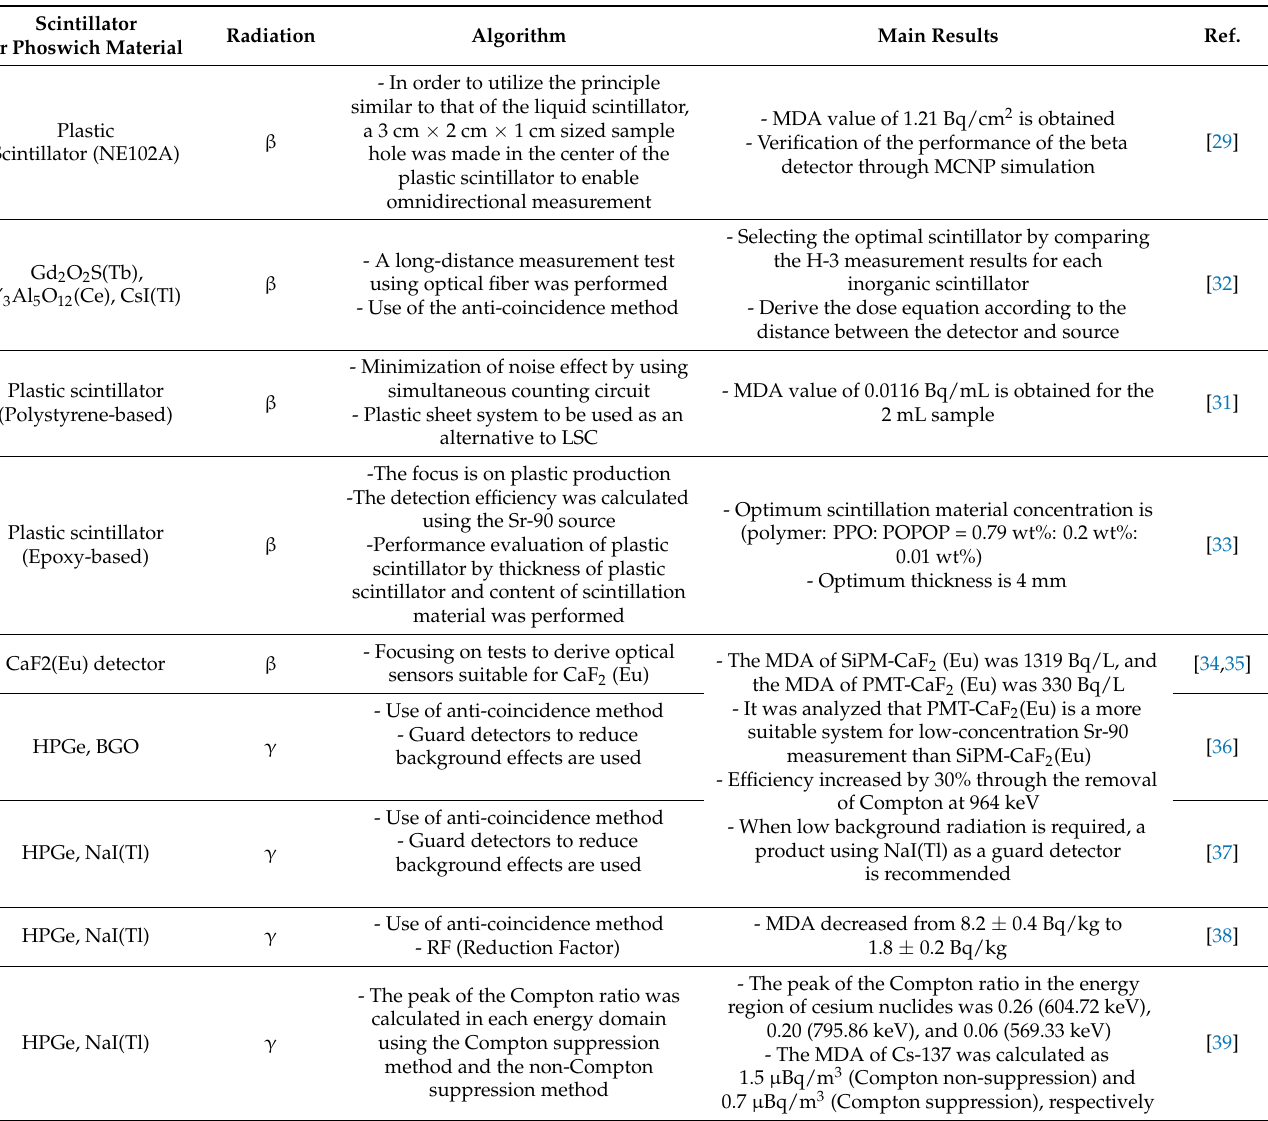
Figure 30. Scintillation decay curves measured with alpha and gamma irradiations on the CsI:Tl and the GGAG single crystal ( a ), and the GGAG/CsI:Tl Phoswich detector ( b ) [62]. In most studies on gamma ray measurement, an inorganic scintillator is used, and an Table 5. Summary of integrated multiple-detection systems in radiological measurements. organic scintillator is used for beta-ray measurement. In addition, multiple detectors are Scintillator Radiation Algorithm Main Results or Phoswich Material